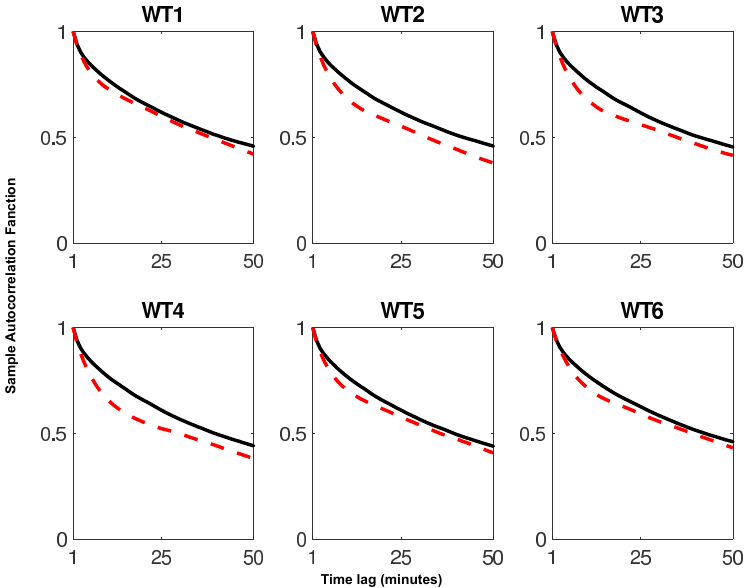
Figure 6. Comparison of the sample autocorrelation function for real data (continuous line) and synthetic data (dashed line) for each power